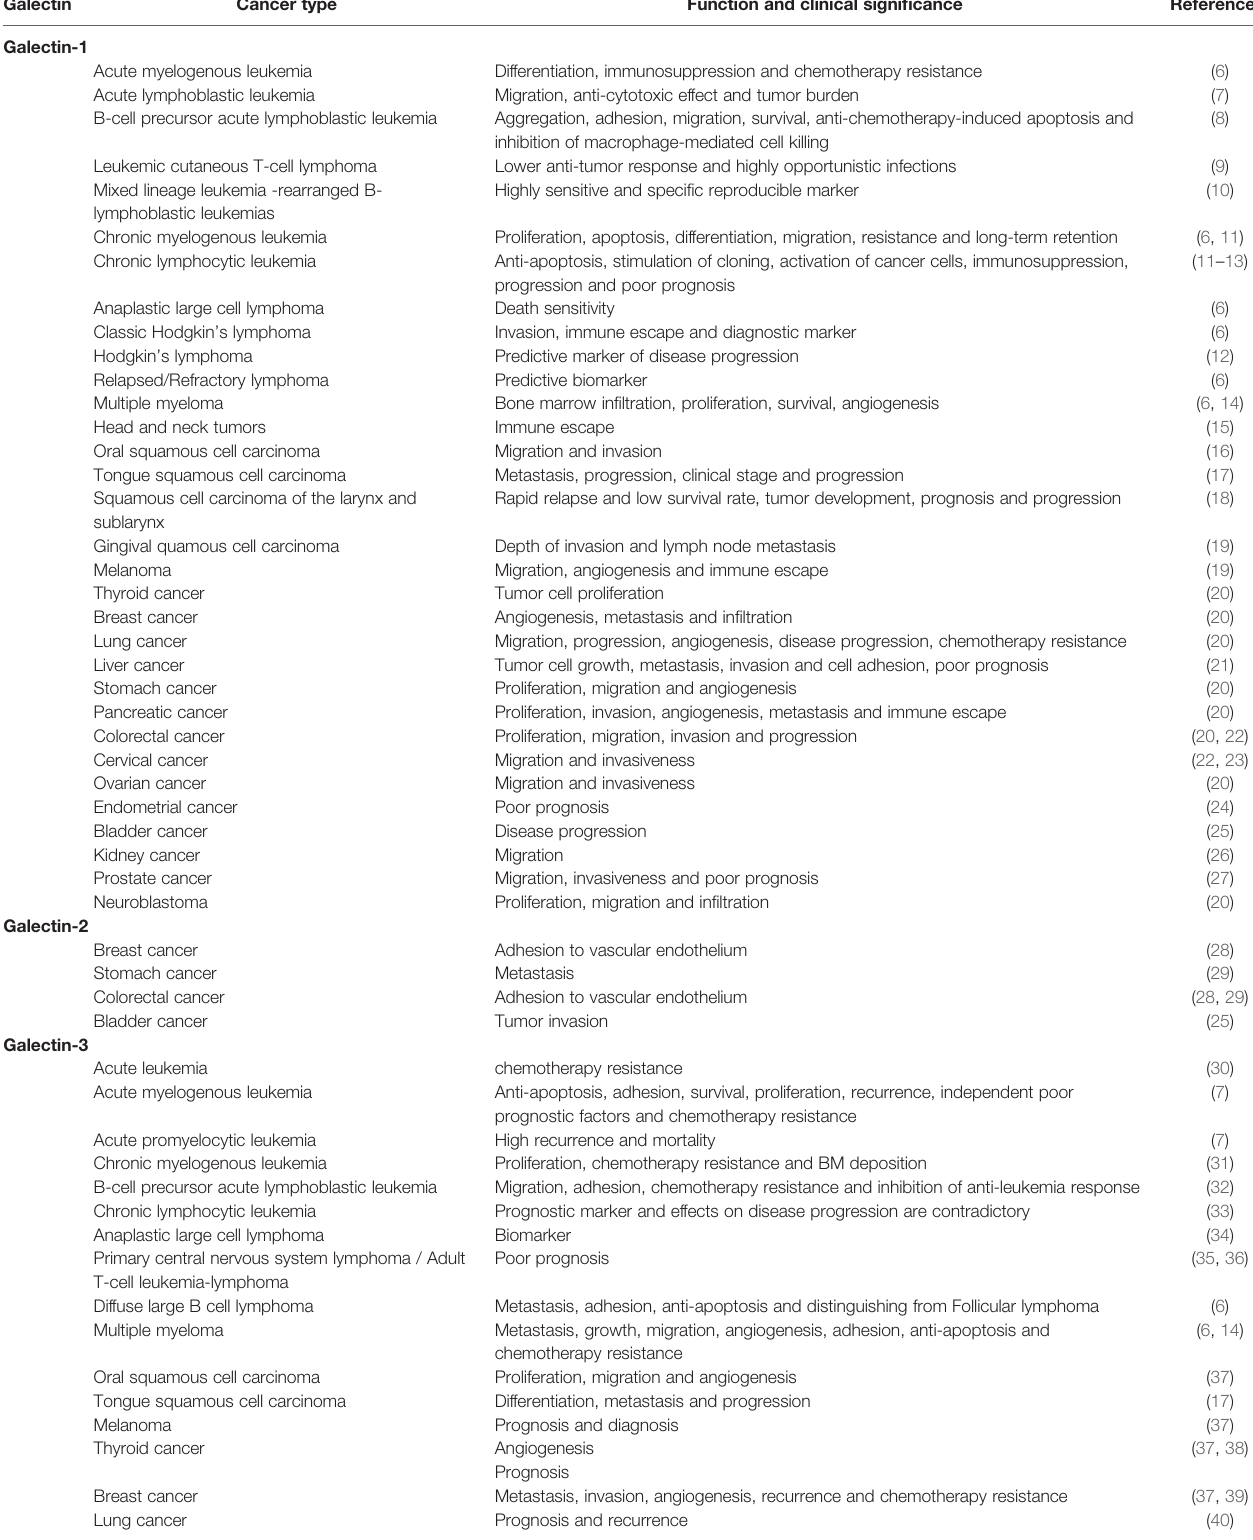
TABLE 1 | The role of galectin in various